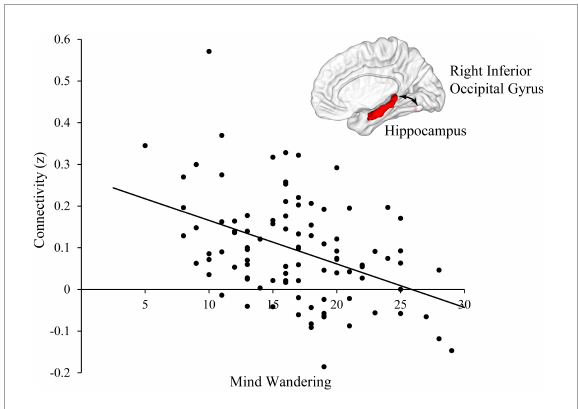
FIGURE1 Mind wandering was negatively correlated with functional connectivity between hippocampus and right inferior occipital